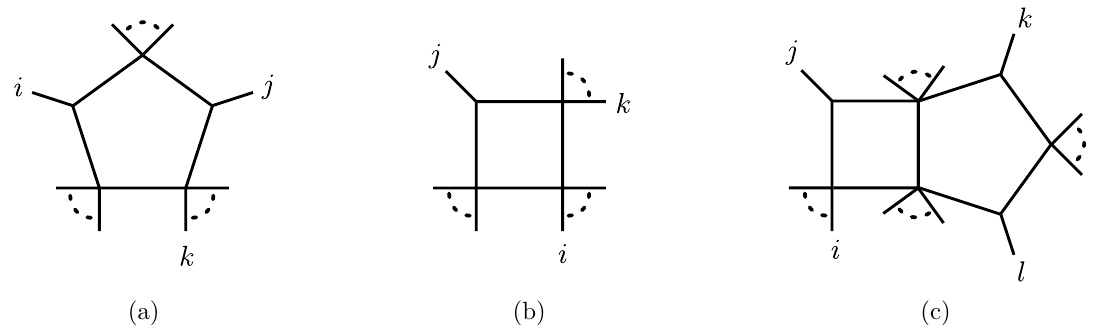
Figure 1. Three examples of cuts on which MHV amplitudes have no support; these appeared as spurious singularities in the Landau equation analysis of [17] since scalar pentagon and double pentagon integrals do have these